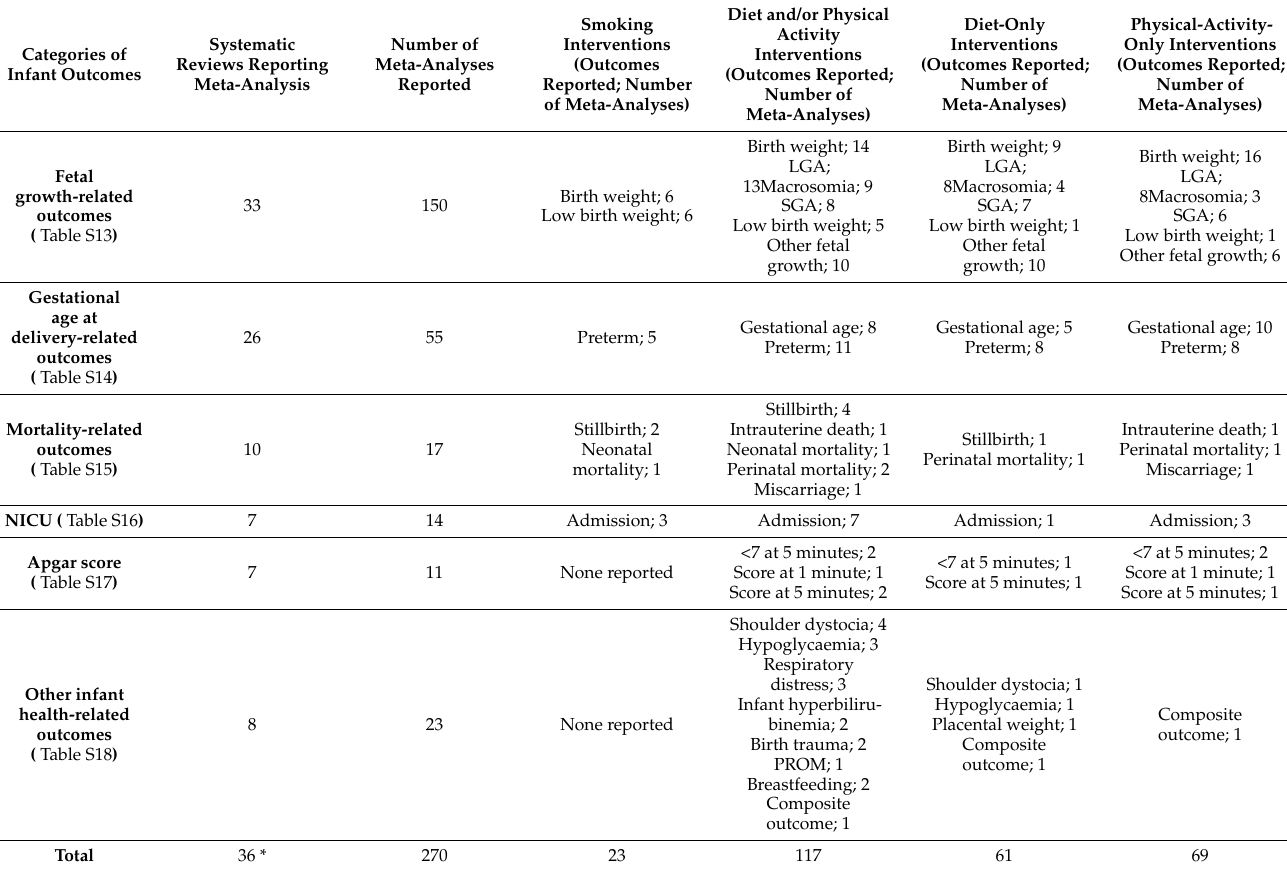
Table 4. Summary of meta-analysis of maternal health outcomes reported by the included systematic